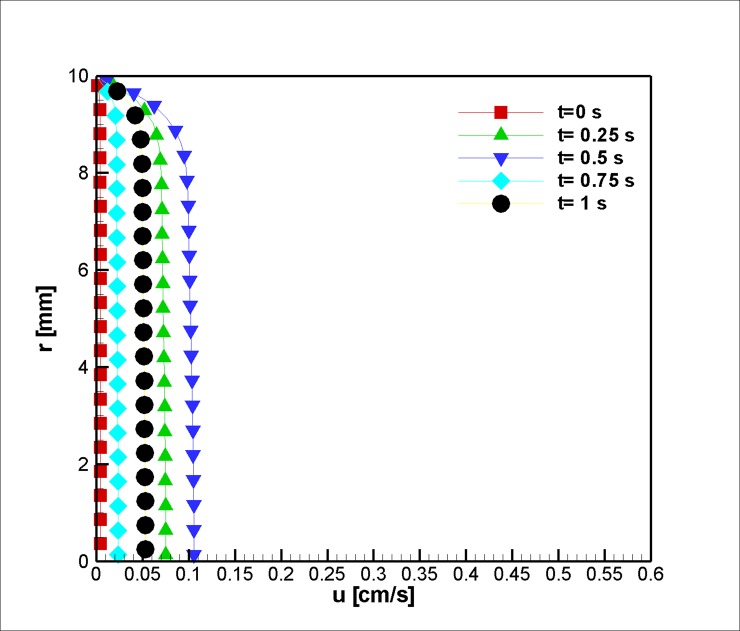
Velocity in the axial direction before stenosis at the inlet at z = 2 mm for the case of Joule heating, Lvessel = 7 cm, Rvessel = 1 cm and a fifty percent stenosis.